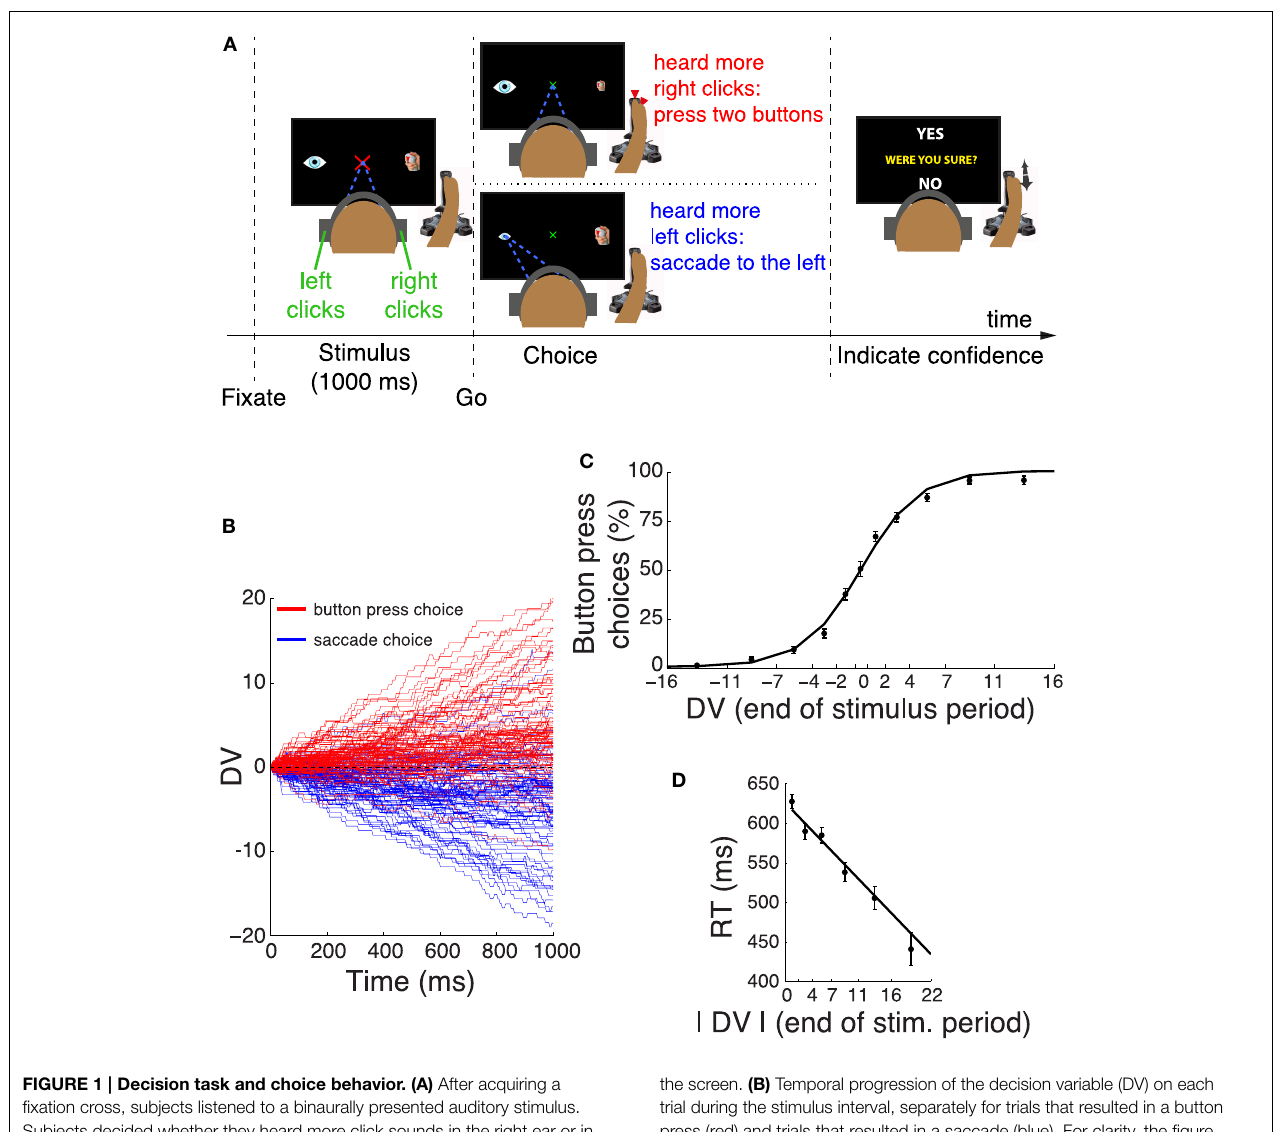
FIGURE 1 | Decision task and choice behavior. (A) After acquiring a fixation cross, subjects listened to a binaurally presented auditory stimulus. Subjects decided whether they heard more click sounds in the right ear or in the left ear. If subjects heard more clicks in the right ear, they pressed two buttons of the joystick with their right index finger and the thumb. Otherwise, they made a saccade to the eye icon on the left side of the screen. After the choice, subjects indicated whether they were sure or unsure about the choice by moving the joystick to YES or NO tags, respectively. One of these tags randomly appeared in the upper part and the other in the lower part of